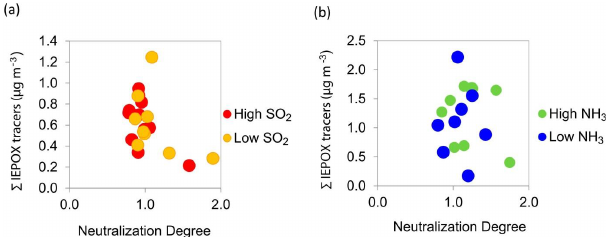
Fig. 10. Effects of aerosol acidity on IEPOX-derived SOA formation: (a) SO 2 conditional samples; (b) NH 3 conditional samples. The sum of IEPOX-derived SOA tracers was enhanced with less-neutralized (i.e., more acidic) aerosols for SO 2 conditional samples, but no clear associations were observed for NH 3 conditional samples.